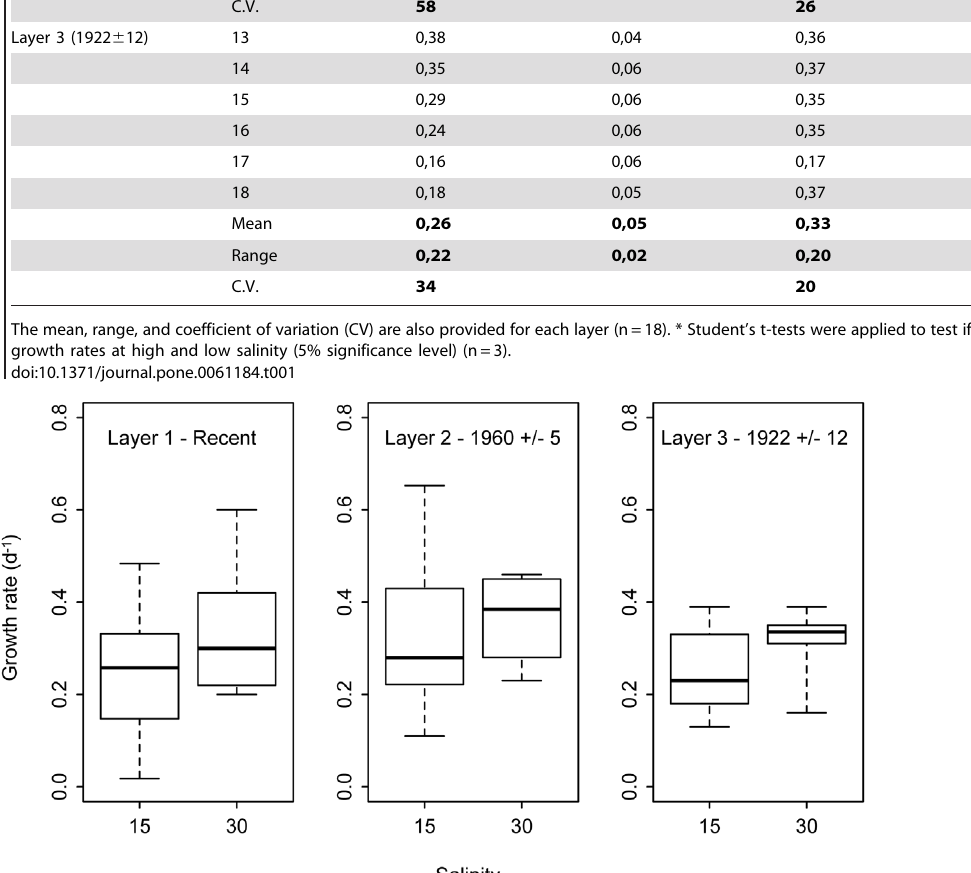
Sediment core layer